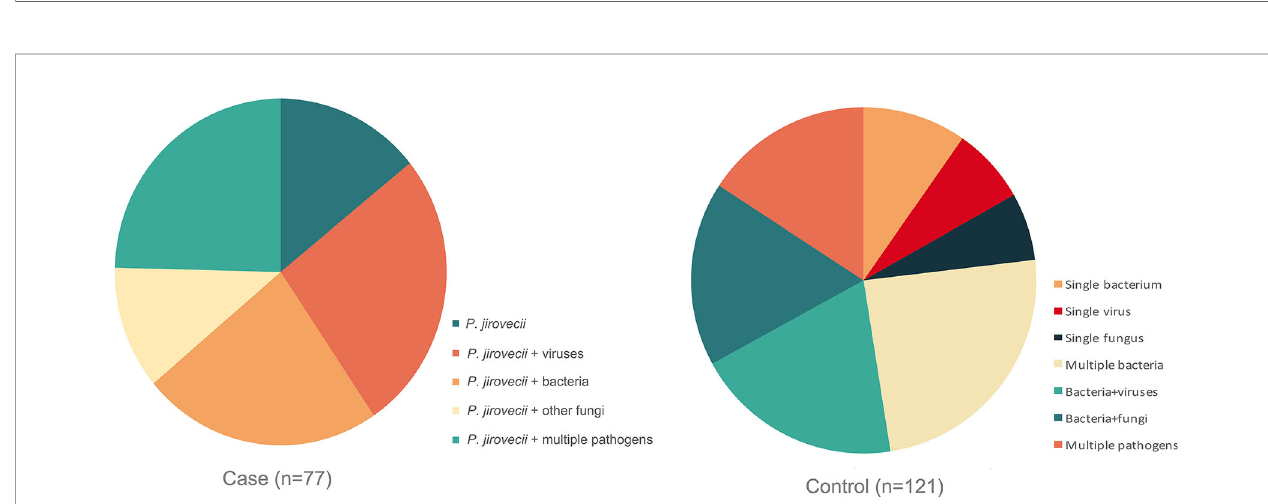
FIGURE 3 | The content of detected pathogens by mNGS in the observation group and control group. Immunosuppressed patients with severe pneumonia were more likely to have mixed